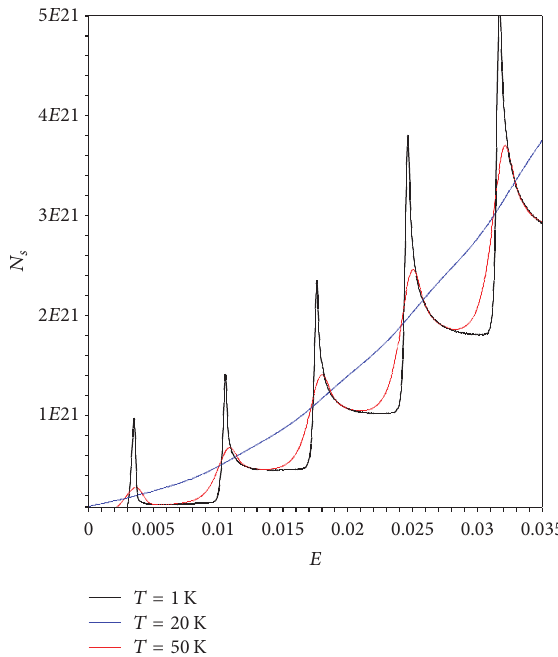
Figure 2: Temperature dependence of the density of energy states in a quantizing magnetic field is calculated using a model